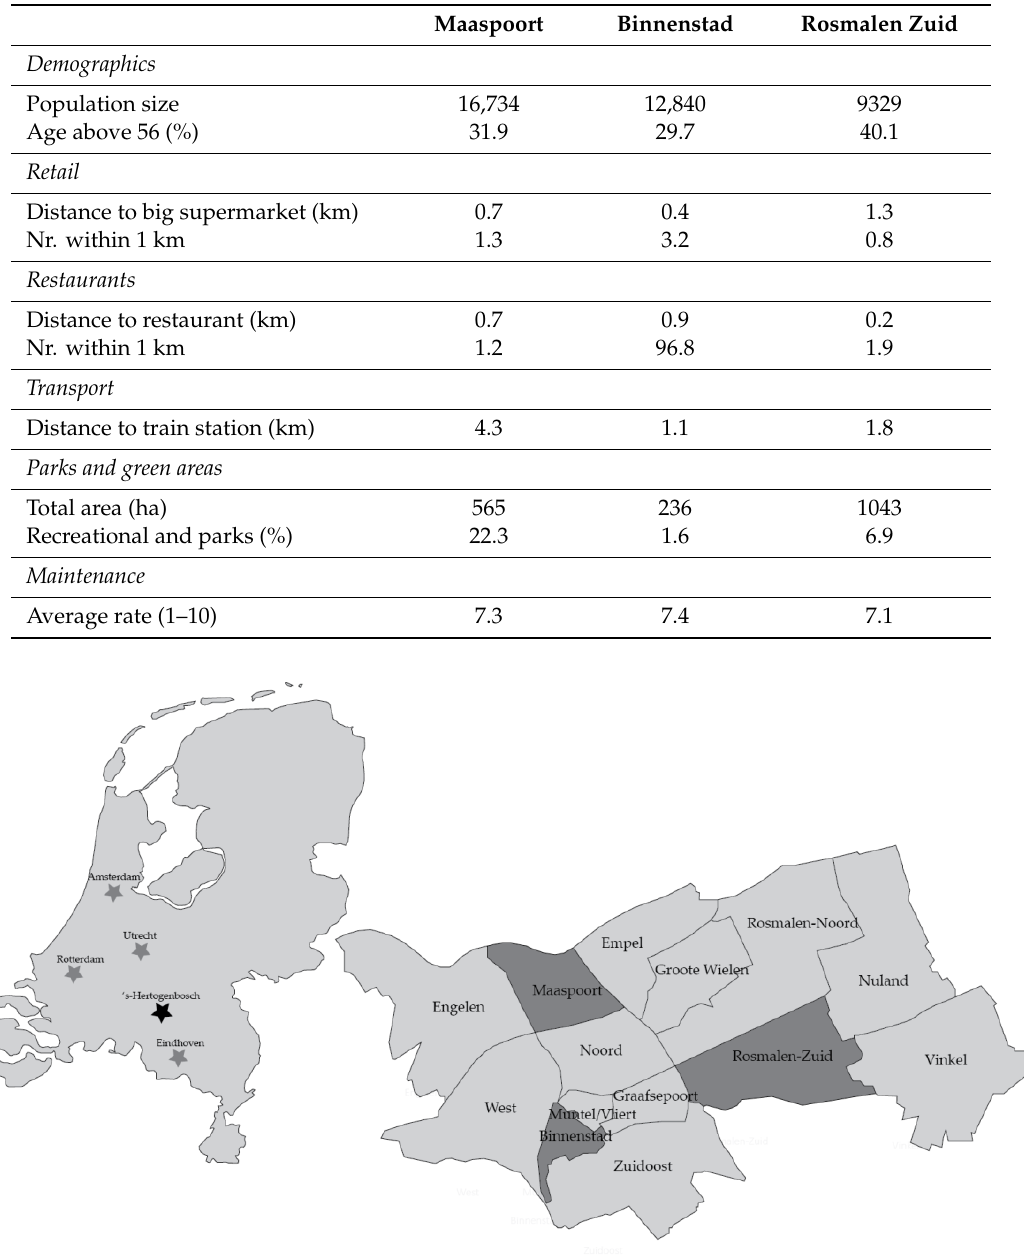
Figure 2. Three selected neighborhoods in ‘s-Hertogenbosch, the Netherlands.